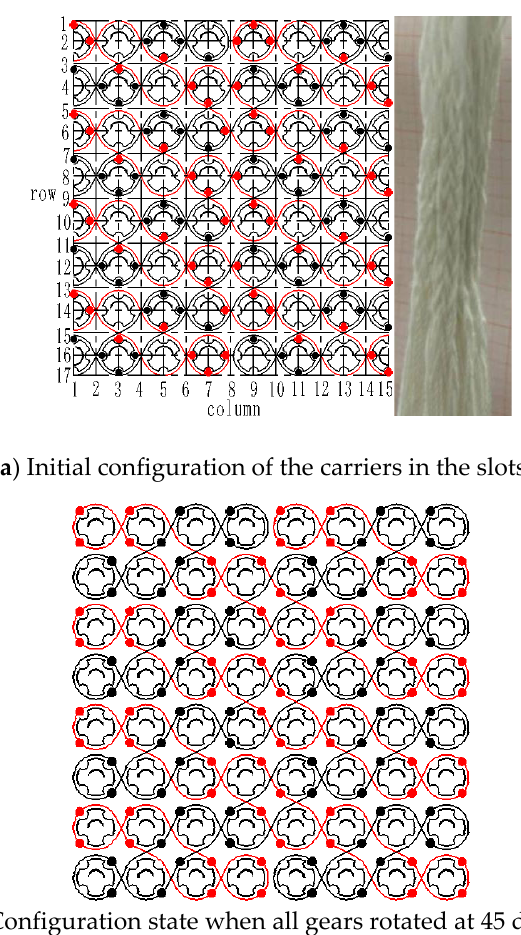
Figure 8. Arrangement of carriers for the rectangular shape by 484 cross-break track and its fabric.